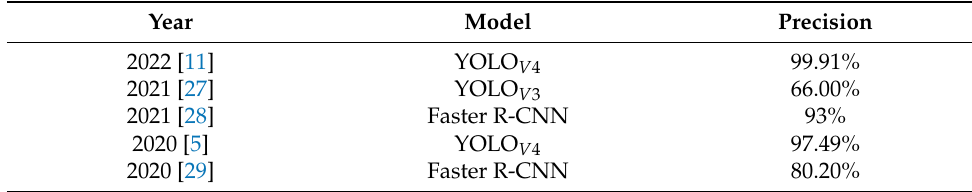
Table 1. Related works